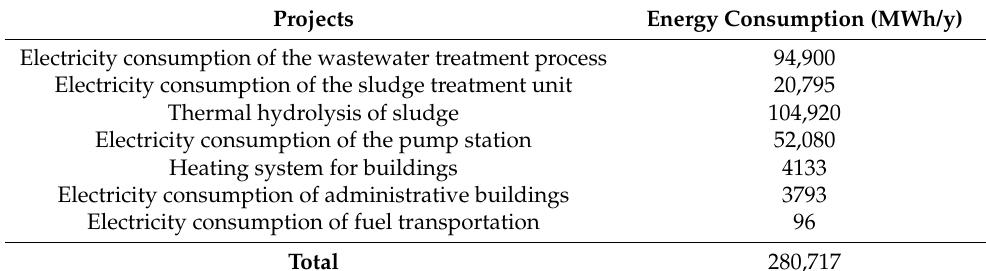
Table 2. Energy consumption of Gaobeidian WWTP